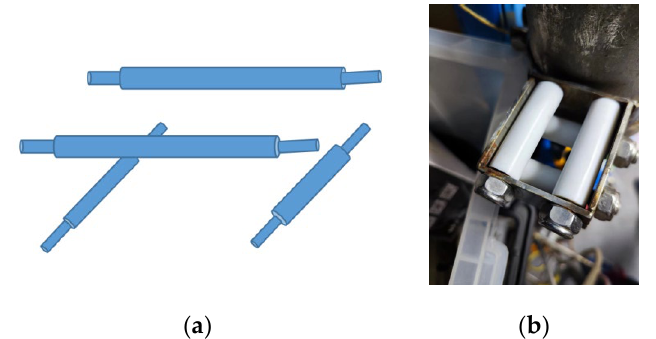
Figure 7. Profile AUV and Kevlar cable connector . ( a ) connector structure drawing . ( b ) connector physical image .